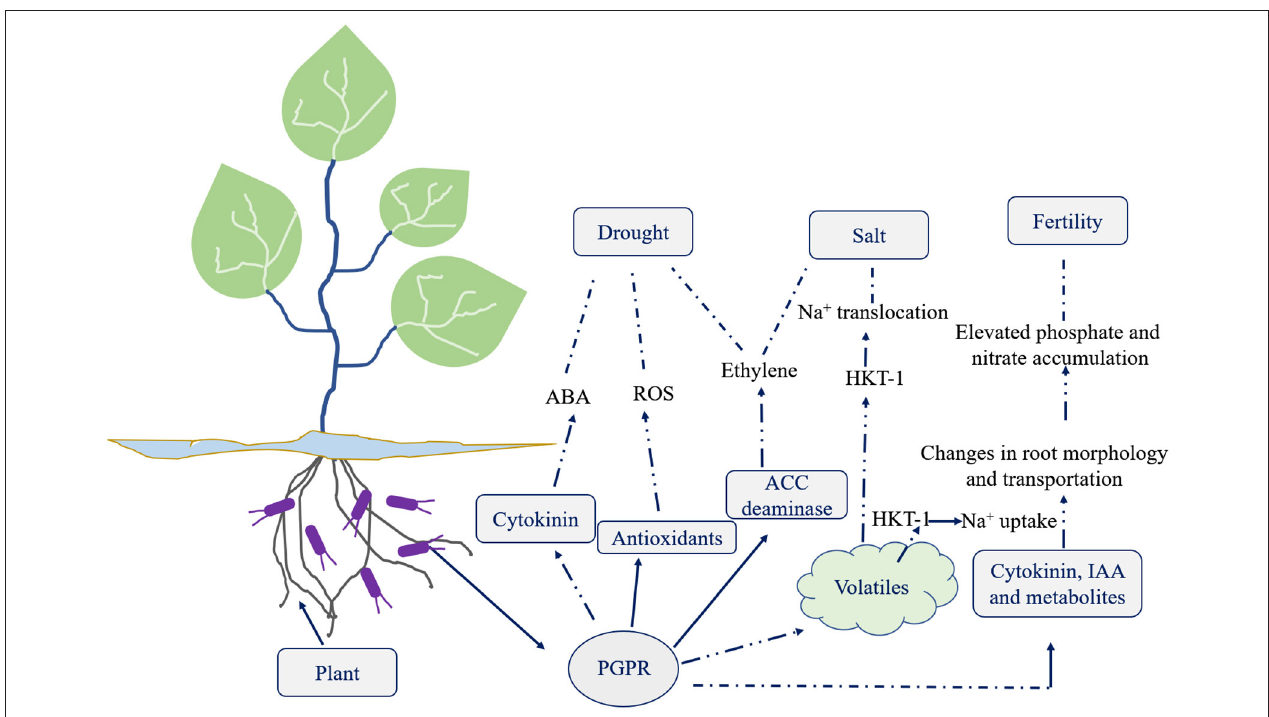
FIGURE 2 | A diagrammatic representation of PGPR role against various